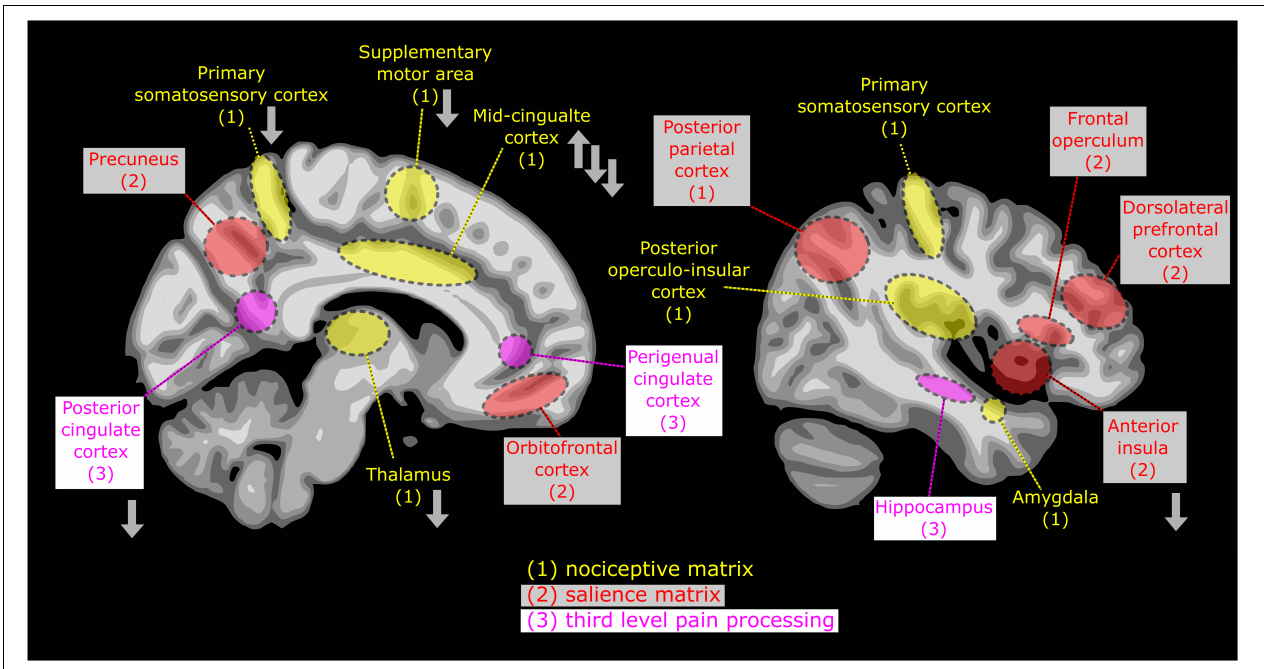
FIGURE 2 | Basic view of ascending pain processing, delineated on two brain sections, with emphasis on early, sub-conscious (1, “nociceptive matrix ”: the posterior operculo-insular cortex, the primary sensory areas, p-mid-cingulate cortex, supplementary motor area and the amygdala) and conscious pain perception (2, “sa lience matrix ”: the anterior cingulate cortex, the anterior insula, posterior parietal, prefrontal and orbitofrontal cortices), and (3, “ areas of third-order brain activation ”: the hippocampus and the anterior and posterior cingulate). Nociceptive cortical processing is initiated in parallel in sensory, motor and limbic areas. Some activation may last longer than voluntary motor reaction. Based on brain response dynamics and models described in Bushnell et al. (42), Garcia-Larrea and Bastuji (70). The alterations in pain-induced responses in the brain of individuals with ASD are shown with gray arrows according to Failla et al. (62), Chien et al. (71), and Gu et al.